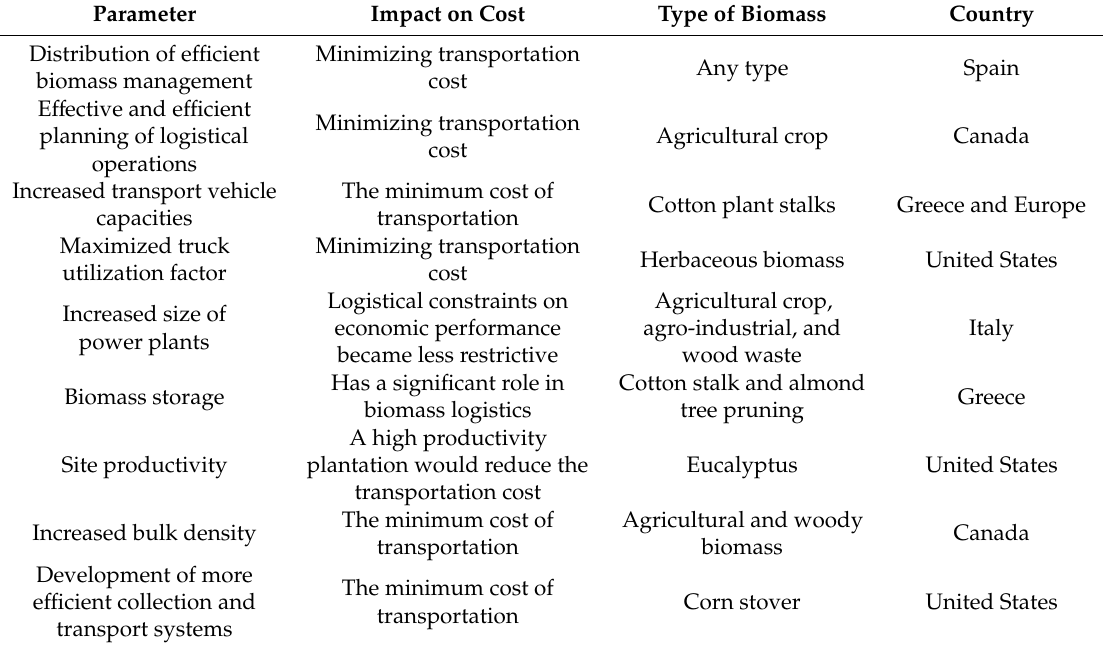
Table 5. Main parameters impacting logistical costs [134].